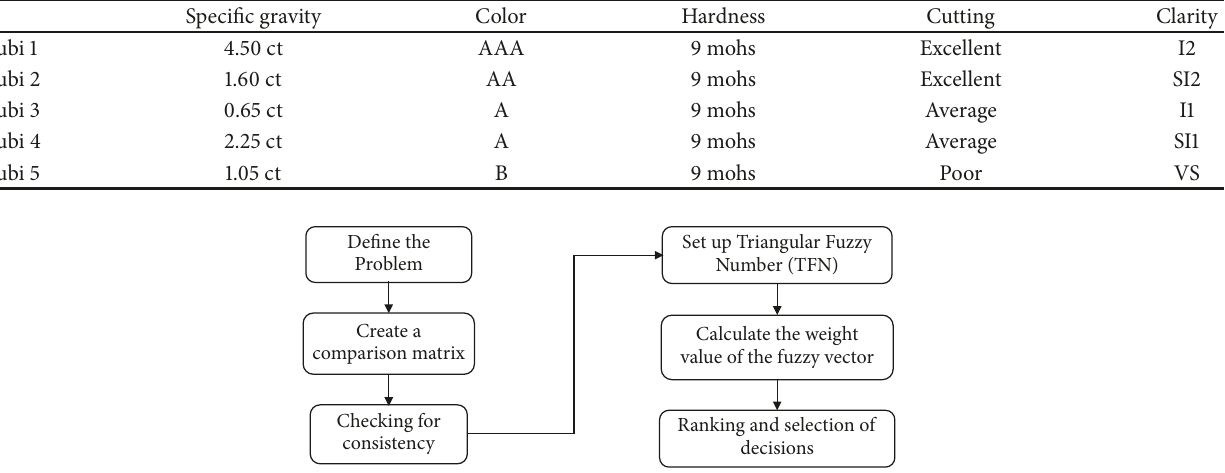
Table 1: Data of gemstones containing specific gravity, color, hardness, cutting, and clarity as the main criteria. The data can be seen from the gemstone certificate.